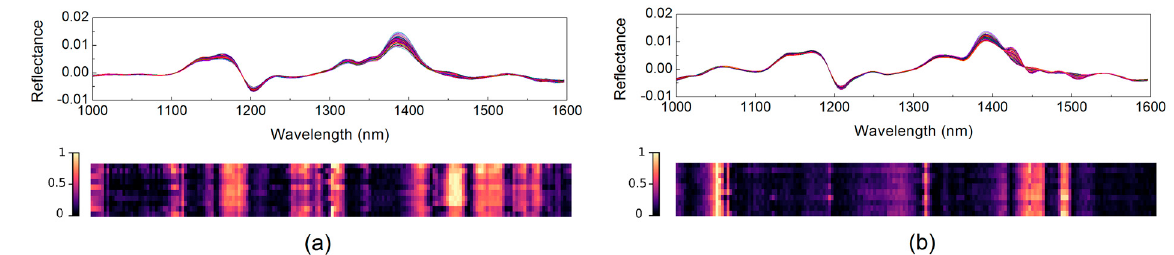
Figure 3. Spectra and weight indicators of the infant formula adulteration data sets: ( a ) hydrolyzed leather protein (HLP) data set; ( b ) melamine data set.